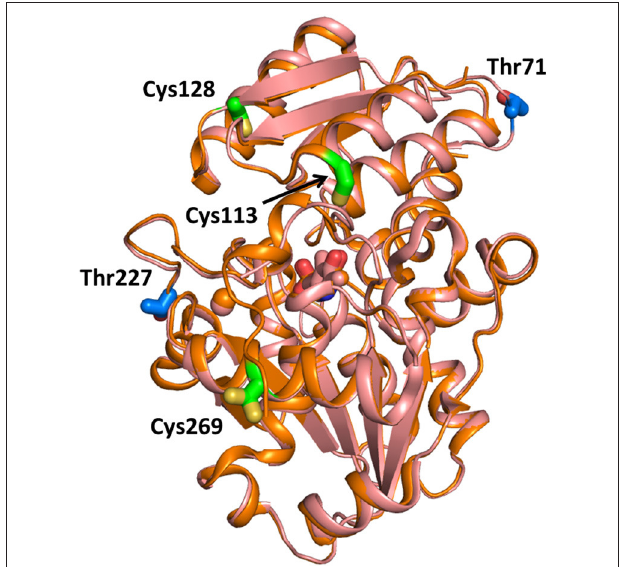
FIGURE 6 | Sites for SR nitrosylation and phosphorylation. The structure of hSR (PDB 3L6B, light pink) and rSR (PDB 3L6C, orange) are superimposed and the positions of the sites for S-nitrosylation (in green on the structure of hSR) and phosphorylation (in blue on the structure of rSR) are reported in sticks. The divalent cation is in pink. Cys269 has two possible positions with 0.5 occupancy based on the PDB